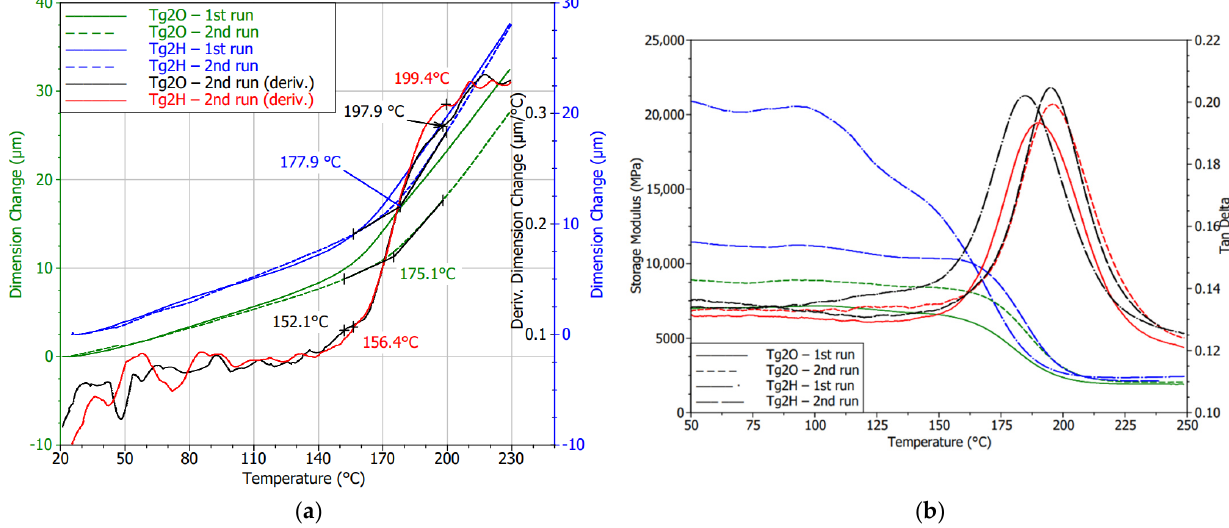
Figure 14. Diagrams of the Tg2 substrate including both surface finishes: ( a ) TMA; ( b ) DMA.